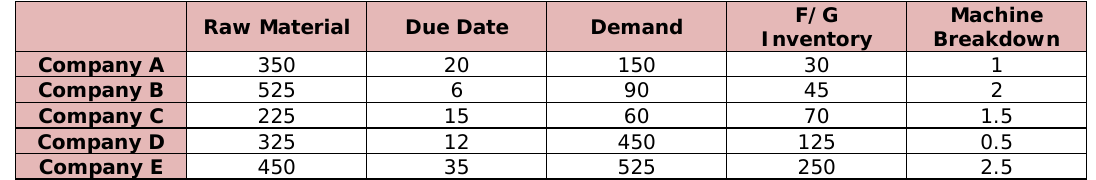
Table 3. “Data of five manufacturing companies”. Source: Own